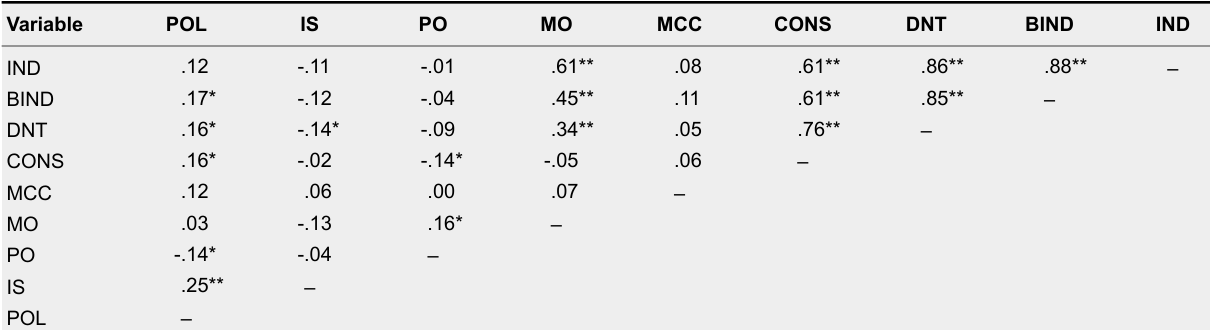
Pearson’s Correlations Between Continuous Variables in Study 2